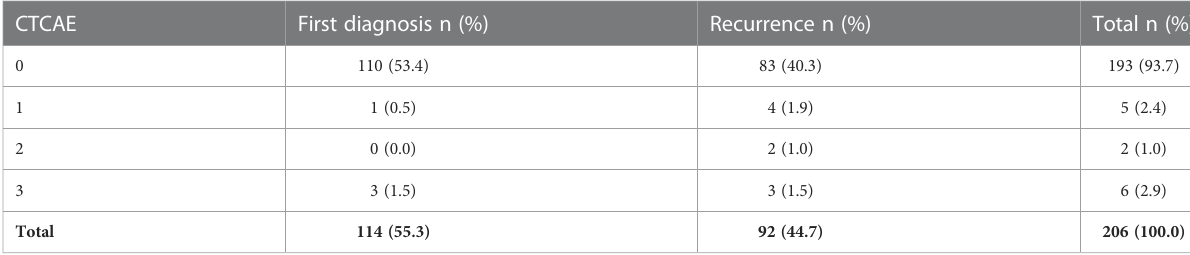
TABLE 6 Clinical complications according severity.